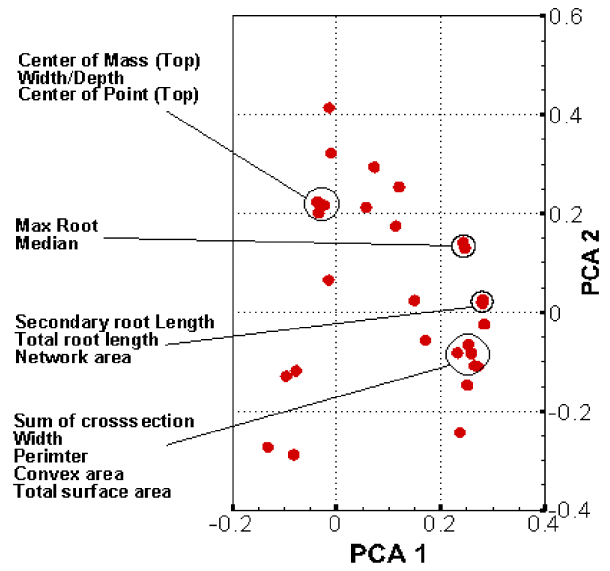
Figure 2. PCA plot of all ARIA trait Pearson correlations, clusters of traits have been marked showing which traits are closest related.